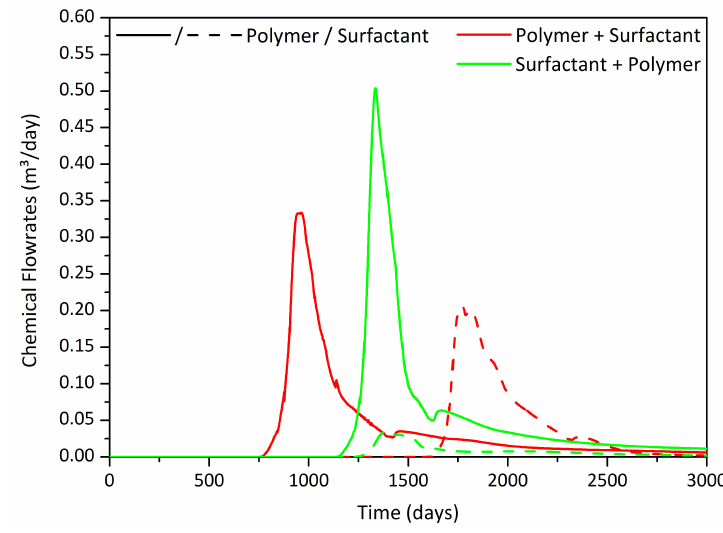
Figure 6. Chemical flowrates for the different SP injection schemes considering the adsorption process.